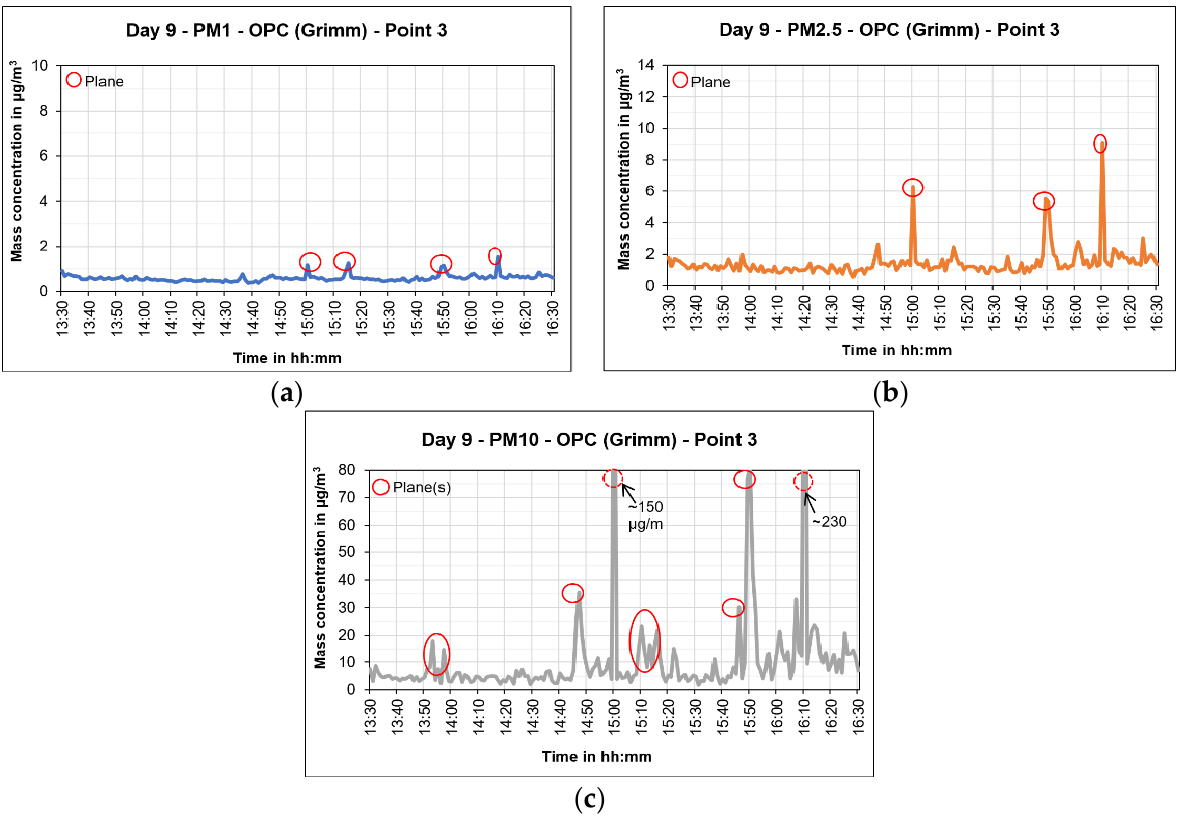
Figure 18. Phase 2 Day 9 ( a ) PM1, ( b ) PM2.5, and ( c ) PM10 levels at point 3. In phase 3, the PM mass concentrations were moderately higher than those in phase 2. The PM1, PM2.5, and PM10 mass concentration results from one of the phase 3 days, i.e., day 14 at point 3 are shown in Figure 19a–c, respectively. It can be seen that the